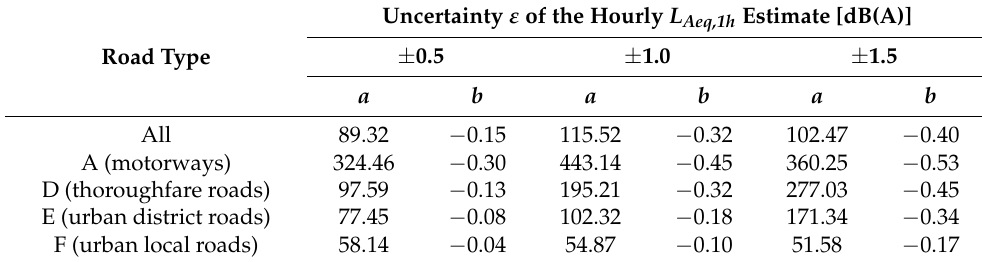
Table 3. Values obtained for the constants a and b in the regression Equation (5).